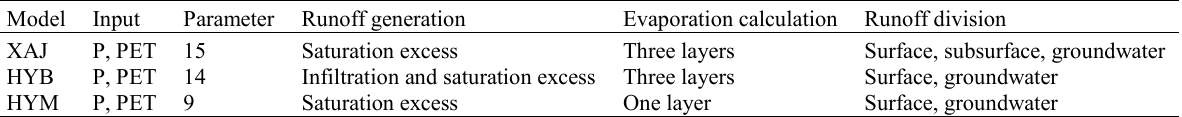
Table 1 The main characteristics of the three hydrological